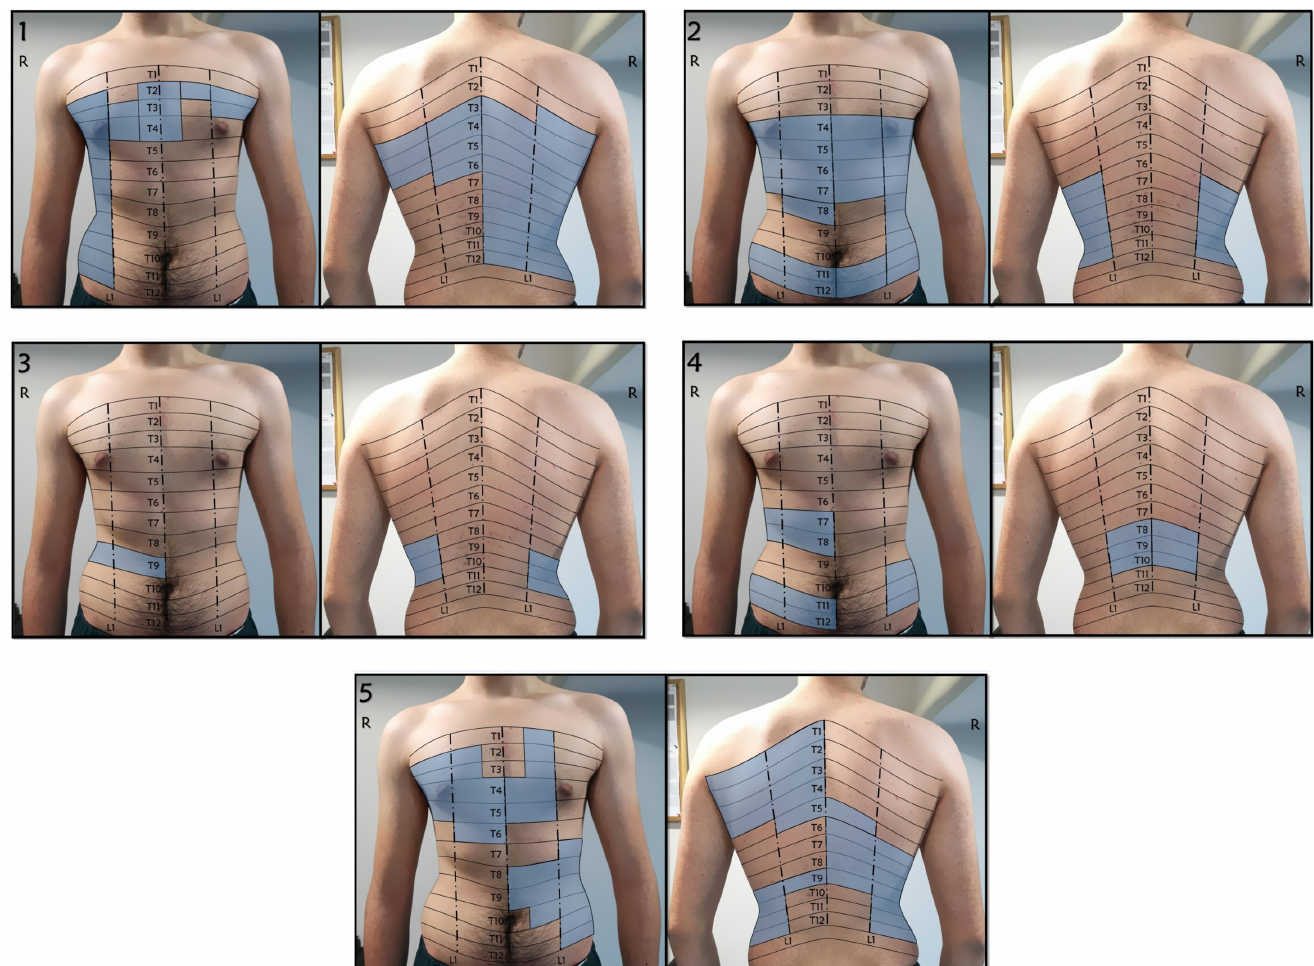
Figure 3. Photo 1-2-3-4-5. Examples of unexpected or patchy involvement following ESPB at T9 level. ESPB, erector spinae plane